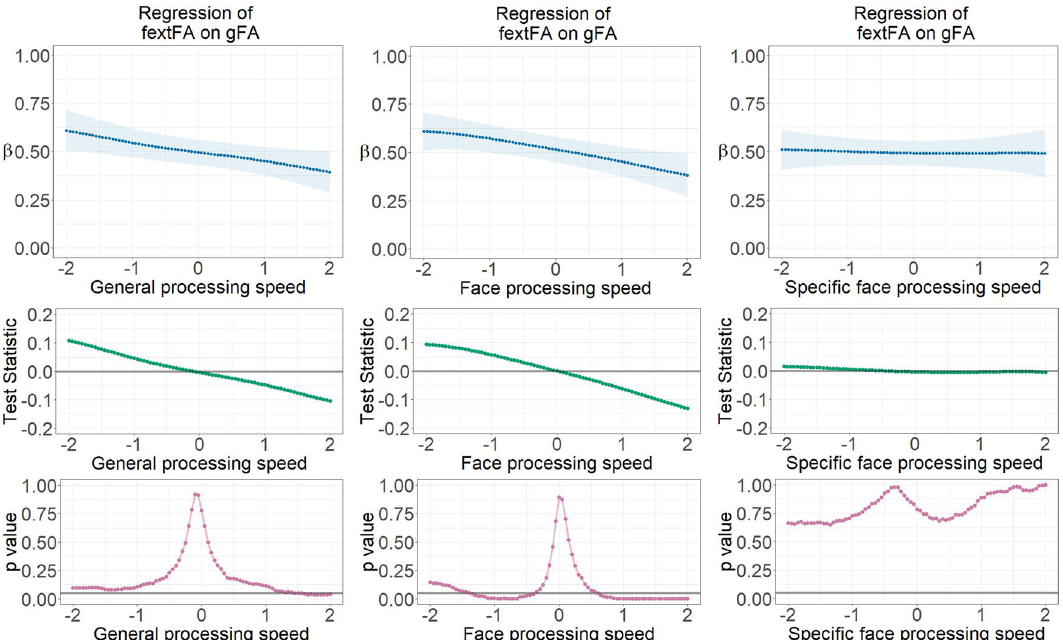
Figure 5. Parameter gradients indicating regressions of fextFA on gFA across continuously assessed processing speed ability scores using LSEM, namely (1) general processing speed ability, (2) face processing speed ability, and (3) specific face processing speed ability with general speed controlled for. The upper row displays variations of locally estimated FA factor regressions across processing speed ability scores—FA factor regression parameter functions. The middle row provides the course of the test statistic across processing speed ability scores as estimated with the permutation test. The bottom row displays the pointwise p -value curve, with p = .05 displayed as a threshold (see the gray horizontal line). β—Standardized regression weight; gFA—Fractional anisotropy in global brain fibers; fextFA—Fractional anisotropy of extended face network